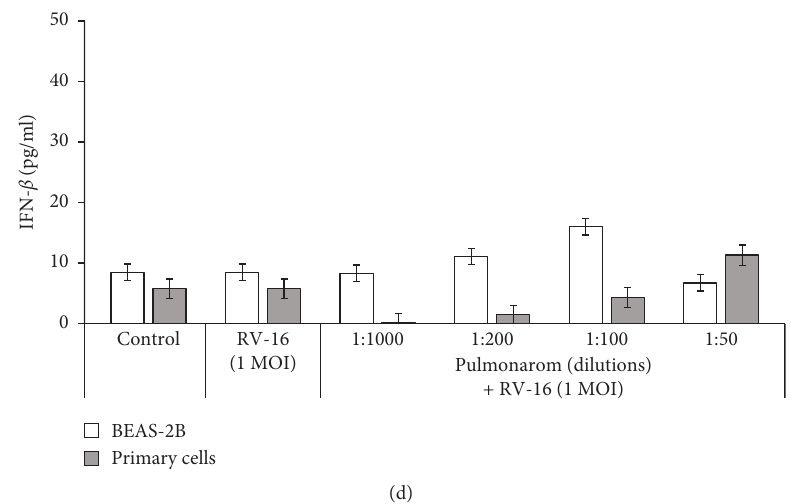
Figure 4: Modification of β -defensin-1 and IFN- β by bacterial lysates. β -defensin-1 release by BEAS-2B and primary cells infected with 1.0 MOI RV-16 after pretreatment with (a) OM-85 or (b) Pulmonarom at different concentrations after 24 hours. IFN- β release by BEAS-2B and primary cells infected by 1.0 MOI RV-16 and pretreated with increasing concentrations of either (c) OM-85 or (d)